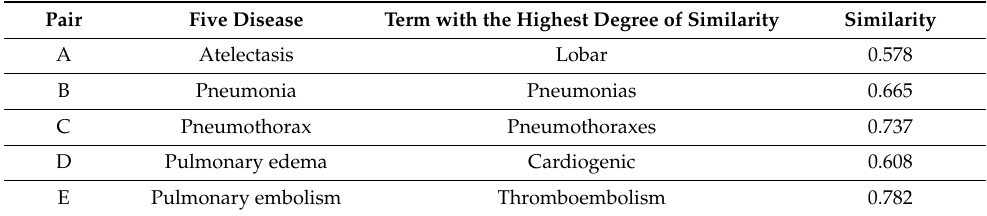
Table 2. Similar terms with the highest degree of similarity correspond to five diseases in the 0:10 ratio